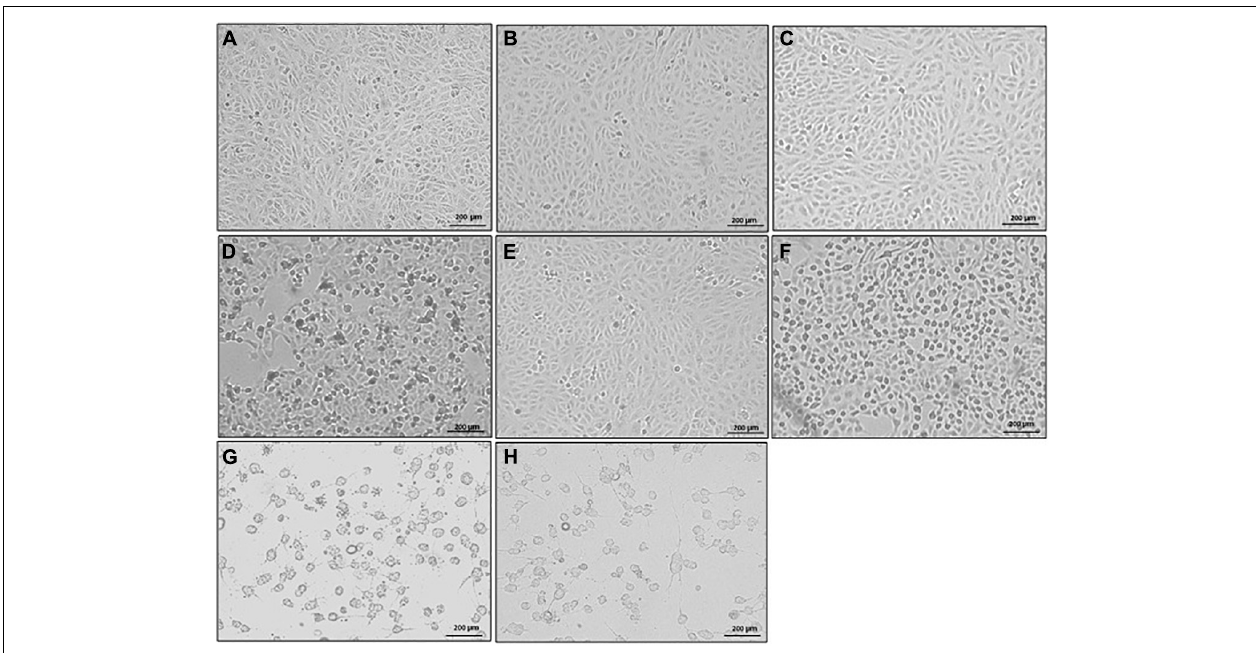
FIGURE 4 | Cytopathic effect (CPE) of different sequence type (ST) strains on Vero cells (light microscope). Stool filtrates were incubated with cells, at 37 ◦ C for 24 h. Following incubation, cells were visualized by scanning electron microscope. Representative images of (A) Vero cells only, and Vero cells treated with (B–H) ST2, ST4, ST6, ST13, ST37, ST42, and ST104-positive stool supernatants, respectively. Scale bar: 200 µ m. n = 3.